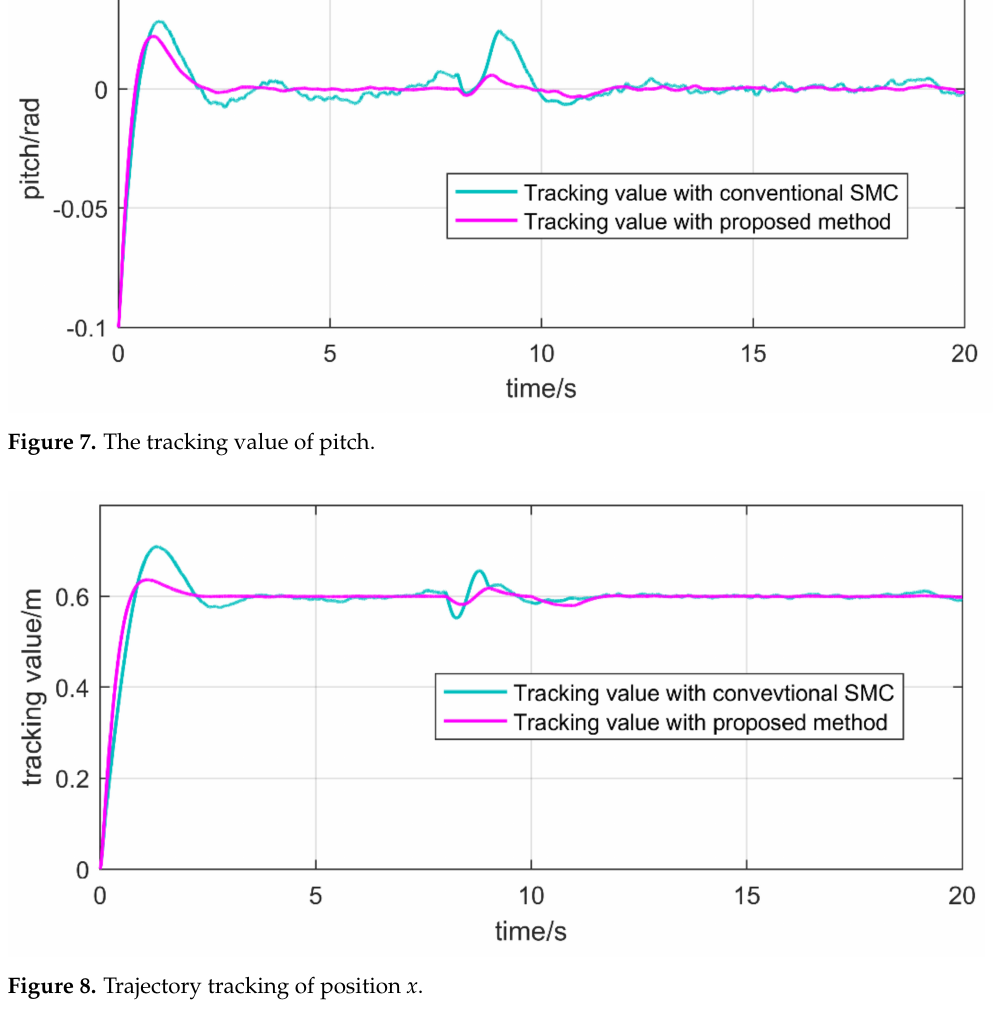
Figure 8. Trajectory tracking of position x .